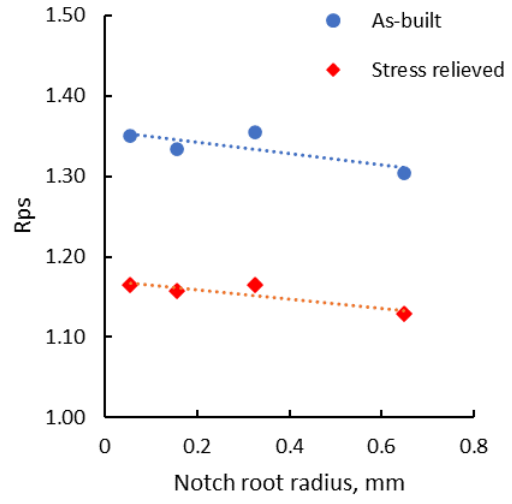
Figure 11. Normalized proof strength of notched test pieces as a function of notch root radius.